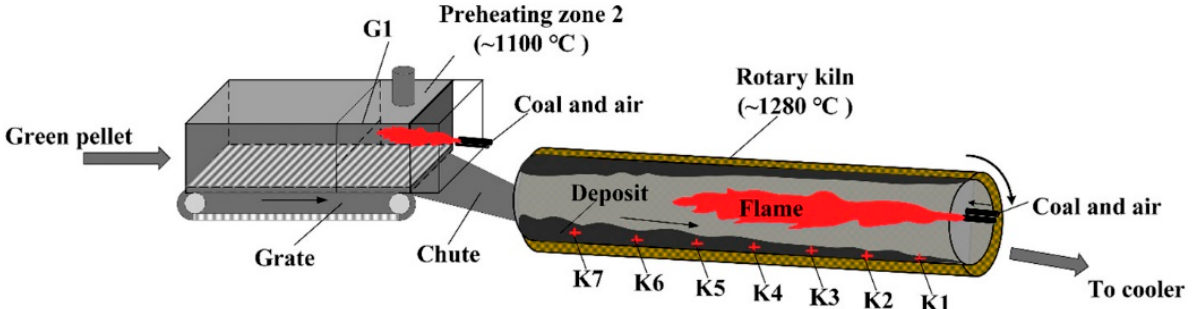
Figure 2. Schematic diagram of the grate-kiln plant [27] .